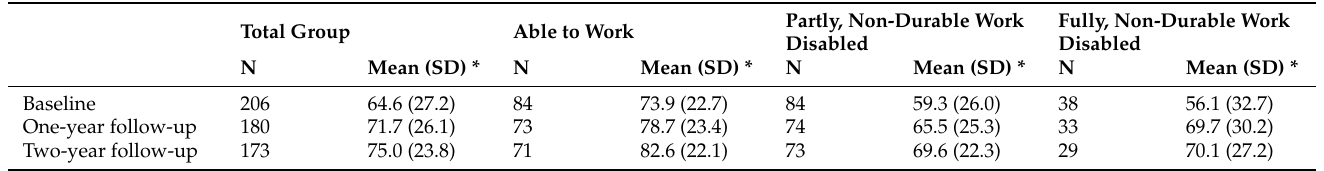
Table 2. Means and standard deviations of cognitive functioning for the total group and separate work disability